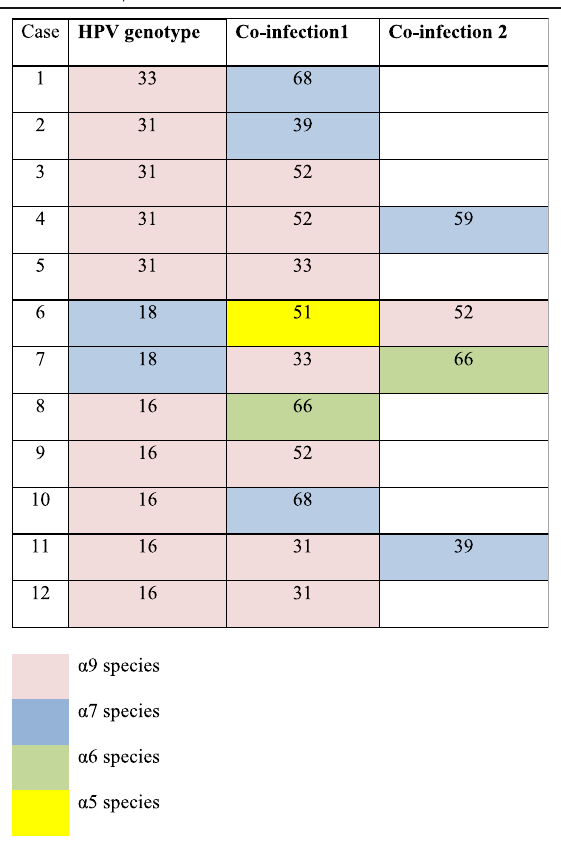
Table 3 HPV genotypes in cases of co-infection highlighing different HPV species in the 12 cases with